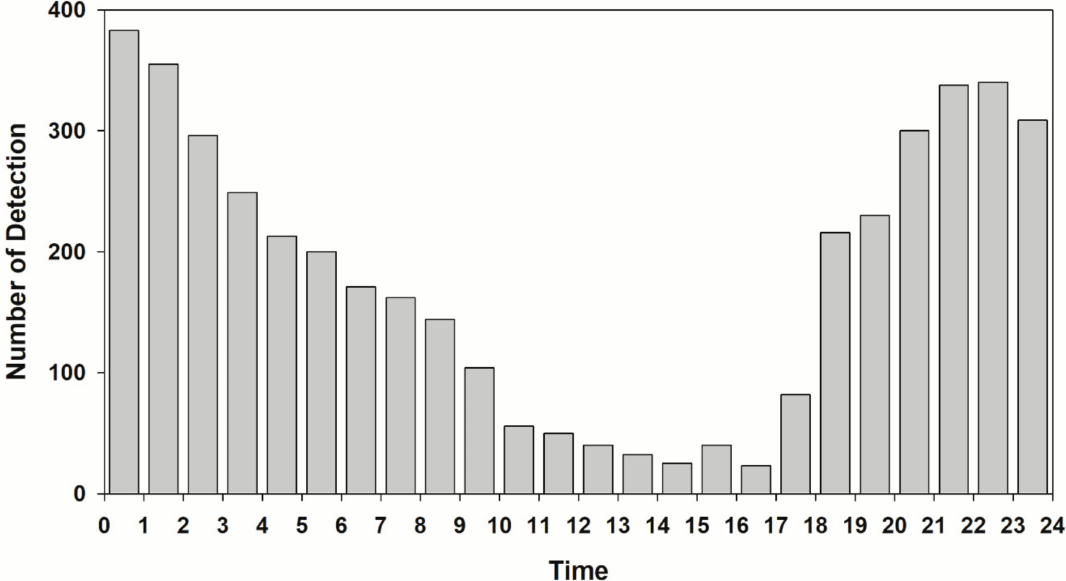
Figure 3. The number of diel detection patterns of tagged A. japonica in the Geum